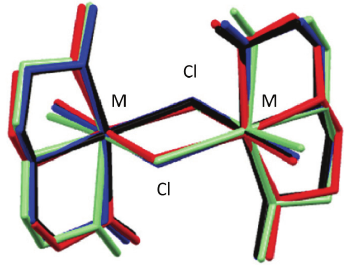
Figure 5. Structure overlay of isostructural complexes [ MCl (diglyme) ] , (M = Fe in red; Mn in green, Ni in blackand Co 2 2 in blue). 13, 15 Hydrogen atoms are omitted for